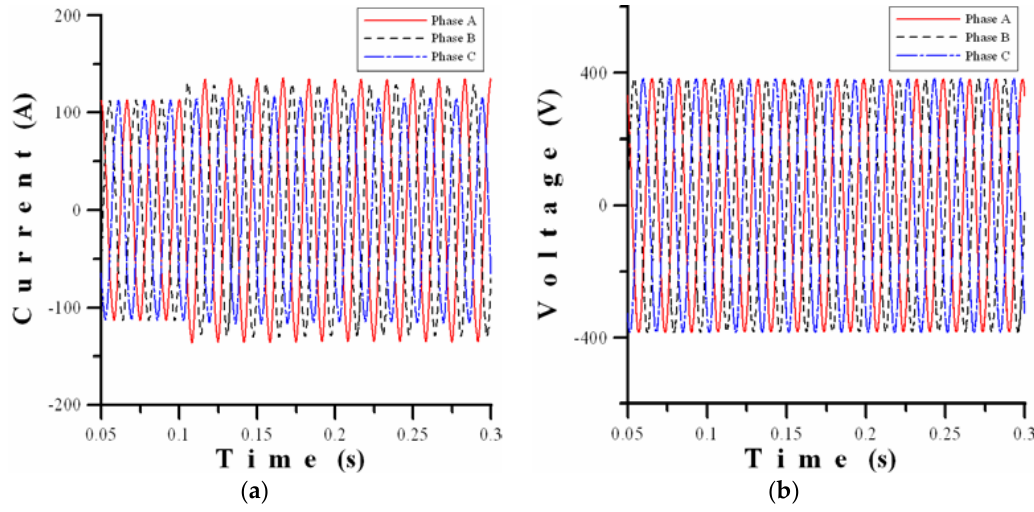
Figure 4. Current and voltage waveforms of SLGF on the phase A for the distribution line 2 of the case study. ( a ) Current waveforms; and ( b ) voltage waveforms.